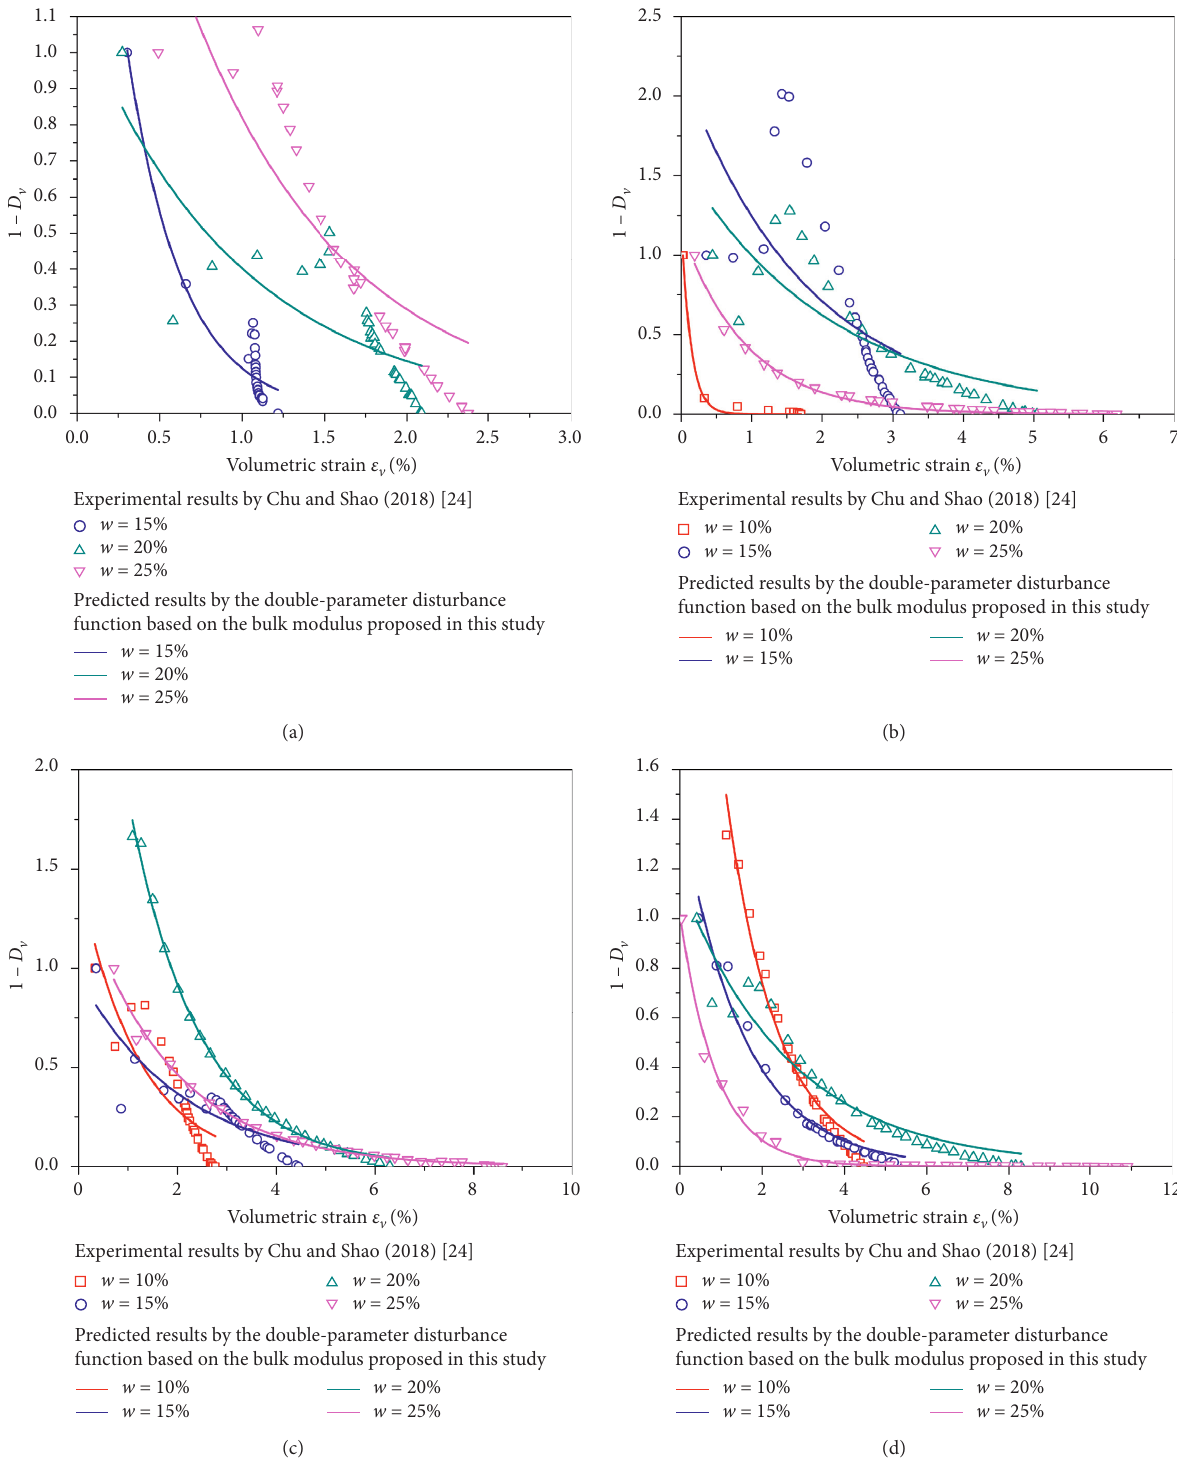
Figure 10: Validation of the double-parameter disturbance function based on volumetric strain against the experimental results by Chu and Shao [24] at different moisture contents and confining pressures. (a) σ 3 � 100kPa; (b) σ 3 � 200kPa; (c) σ 3 � 300kPa; (d) σ 3 �